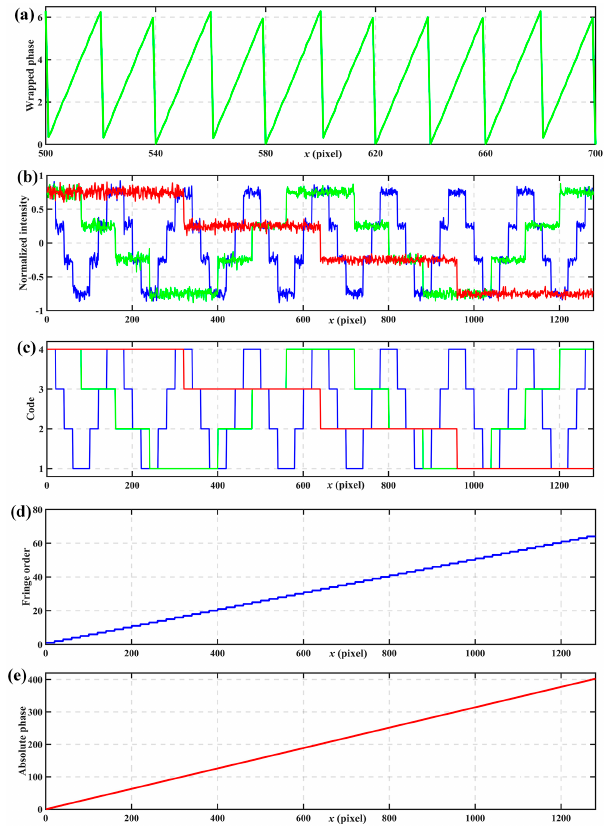
Figure 6. Simulated results. ( a ) wrapped phases, ( b ) coded patterns with intensity normalization, ( c ) codewords calculated from normalization coded patterns, ( d ) fringe orders, ( e ) the calculated absolute phase.